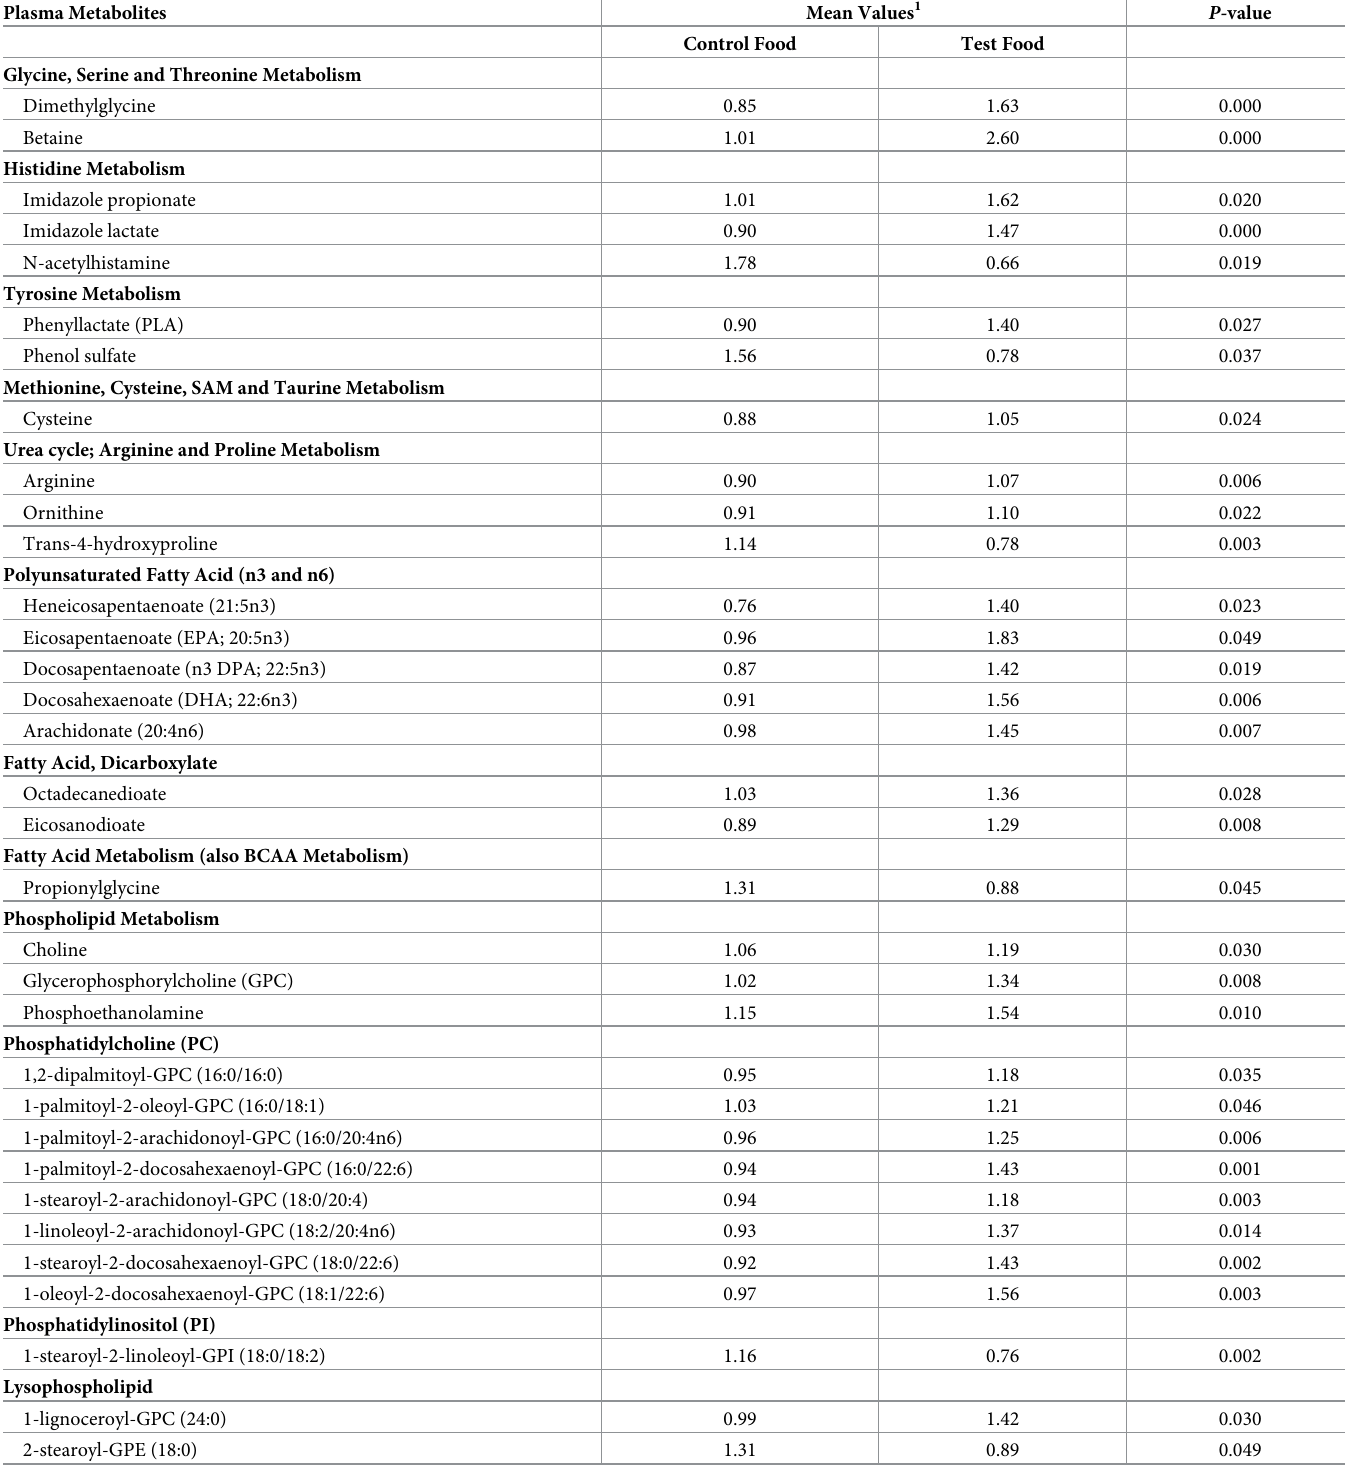
Table 8. Relative concentrations of plasma metabolites that were significantly different ( P � 0.05) in healthy cats after feeding control food (N = 8) or test food (N = 8) for 8